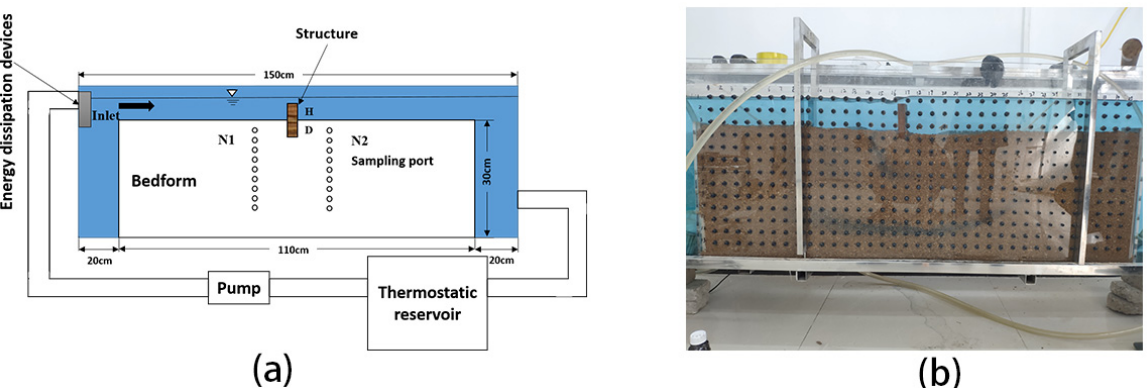
Figure 1. Schematic diagram ( a ) and actual diagram ( b ) of experimental apparatus. The light gray and blue areas represent the parts filled with sand and water, respectively. The dark gray rectangle on the sand bed is the weir set in the experiment. N1 and N2 are two rows of sampling holes with a distance of 5 cm to the structure.